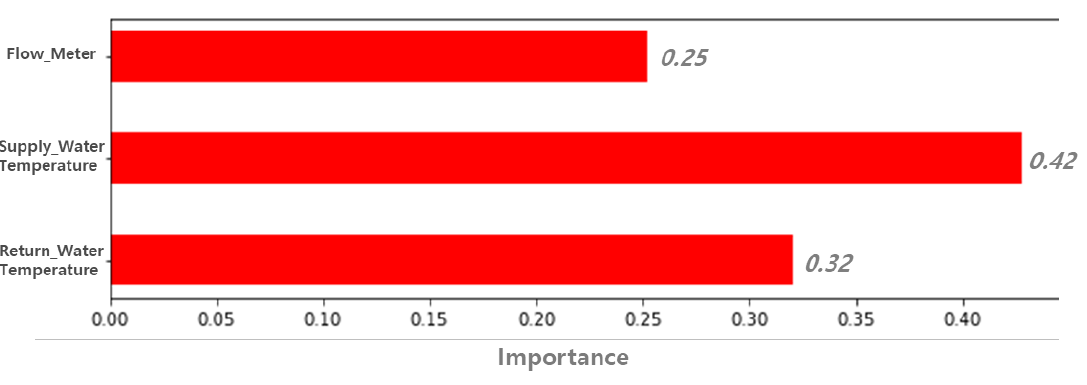
Figure 7. Gini importance of heating supply data.